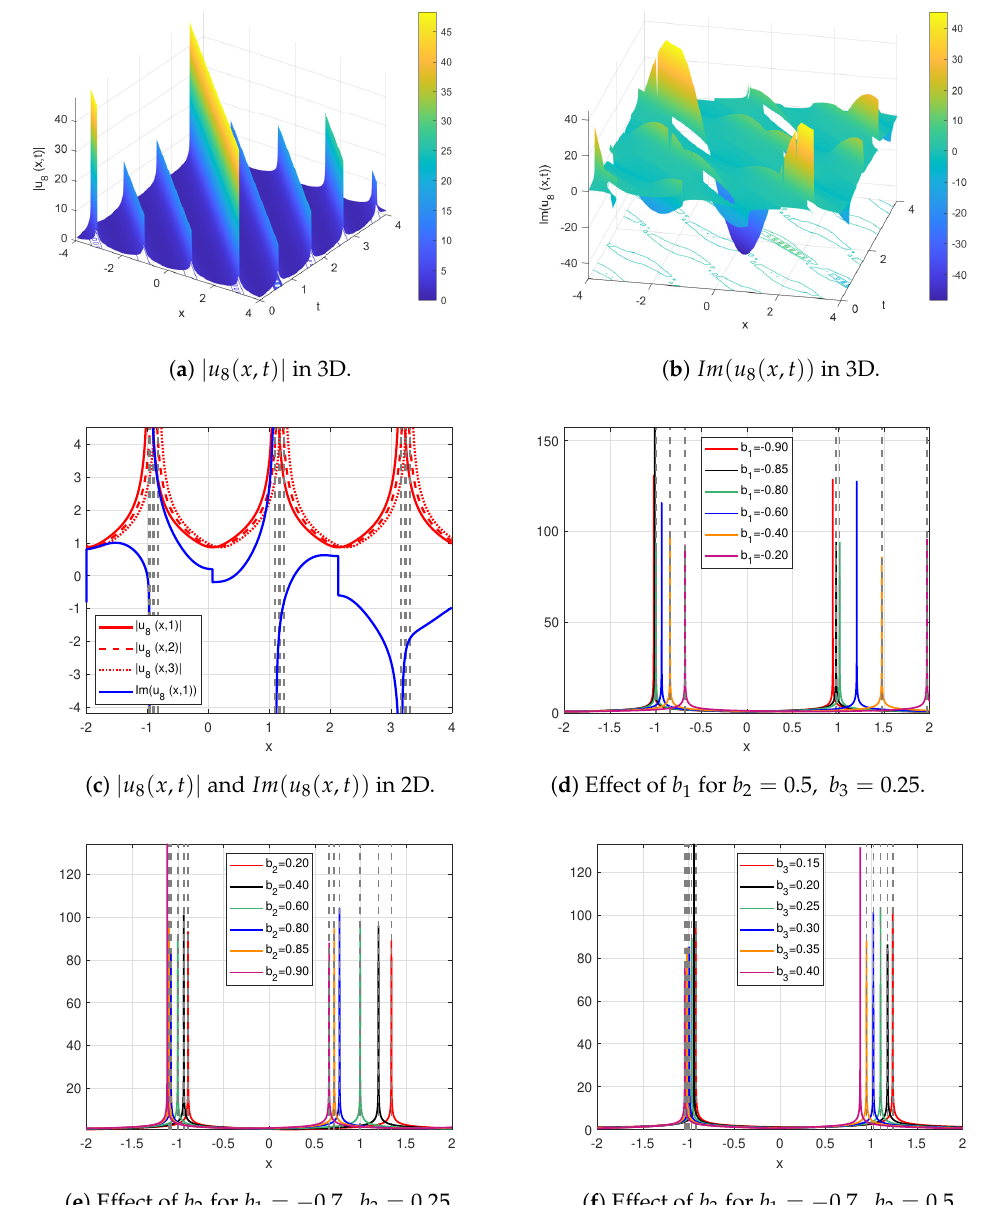
Figure 5. The various simulations of u 8 ( x , t ) in Equation (26) by combination of the Set 5 in Equation (16) and the selected h = 0.04, a = 0.5, φ 0 = 0.5, b 1 = − 0.7, b 2 = 0.5, b 3 = 0.25, κ = 2